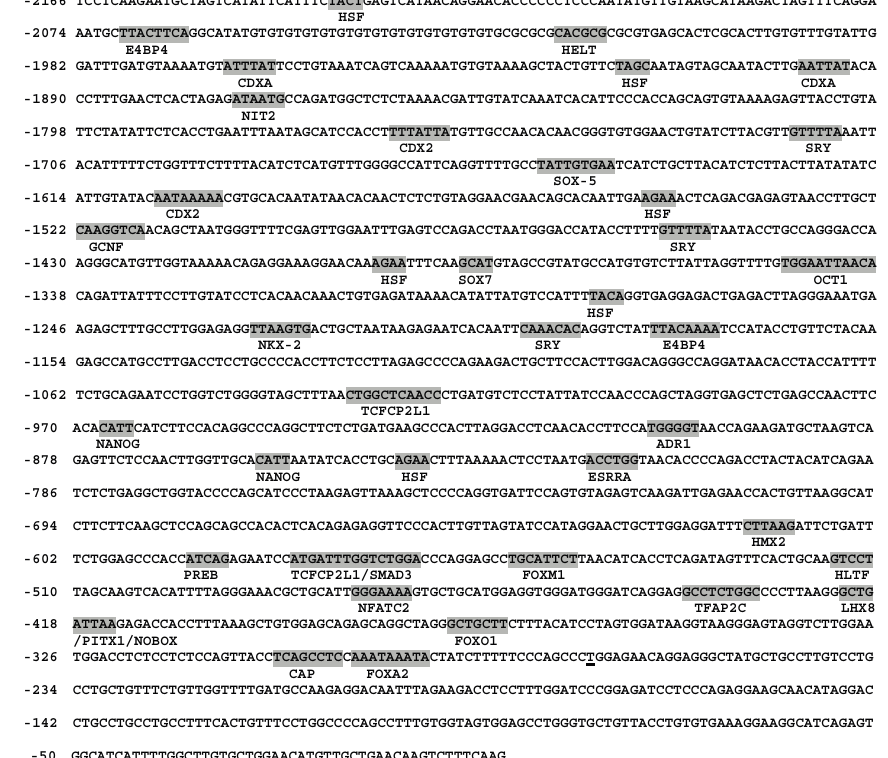
Figure 1. Porcine BMP15 gene 5 ʹ untranslated region (UTR) and transcription regulatory region. The 2166 bp 5 ʹ UTR and promoter region of porcine BMP15 gene was cloned from porcine ovary tissue. The potential transcription initiation site is underlined. The predicted DNA binding sites are